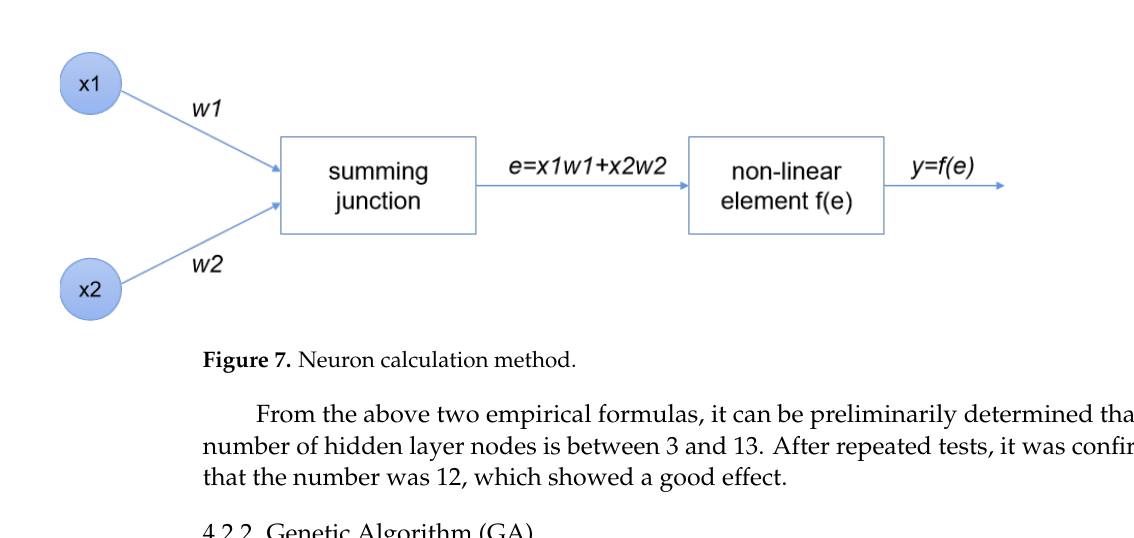
Figure 6. Structure diagram of the BP neural network.